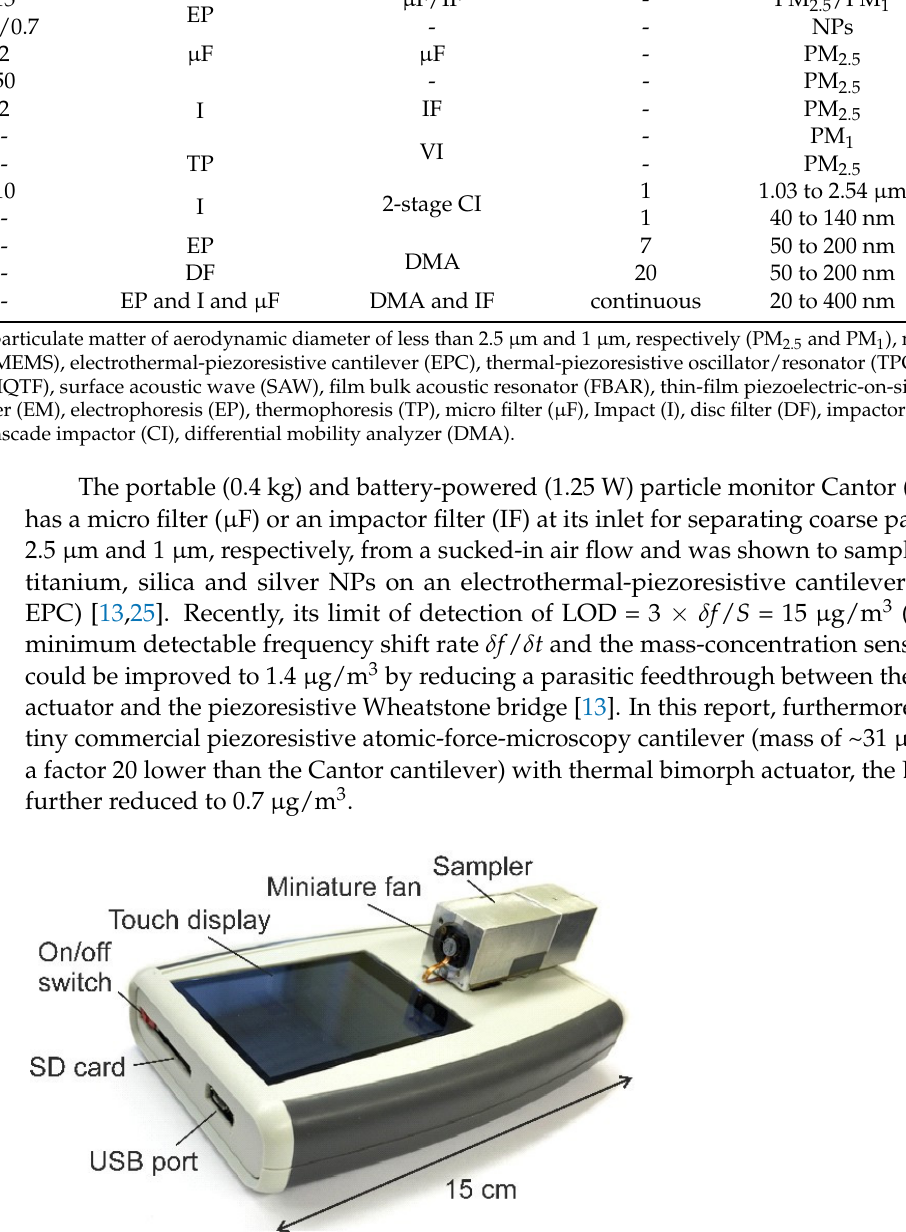
Table 1. Gravimetric aerosol particle detectors for personal air-quality monitoring. For compari- son, three electrometer-based (EM) setups are included offering the capability of particle separa- tion into several size bins. Abbreviations are given below 1 .